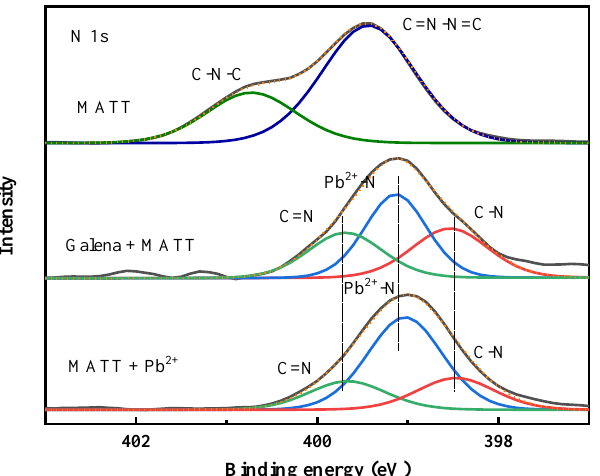
Figure 11. N 1s spectra of galena, galena treated with MATT and MATT treated with Pb 2+ ions. The high resolution spectra of Pb 4f of galena treated and untreated with MATT is displayed in Figure 12. For the original galena sample, the Pb 4f spectra located at 137.50 eV and 142.50 eV were regarded as the characteristic peaks of galena and were coherent with the reported values in previous study [32], while the binding energy located at 138.45 eV and 143.45 eV were due to oxidation products of lead ions on galena surface. After the addition of MATT depressant, the binding energy of PbS was shifted to 137.29 eV and 142.18 eV, lower than that of original galena, while the spectra of Pb oxidizations were still at 138.42 eV and 143.42 eV. The decrease of Pb 4f binding energy demonstrated that the electronic density of lead atom was changed, which might be attributed to the combination of Pb sites and MATT.